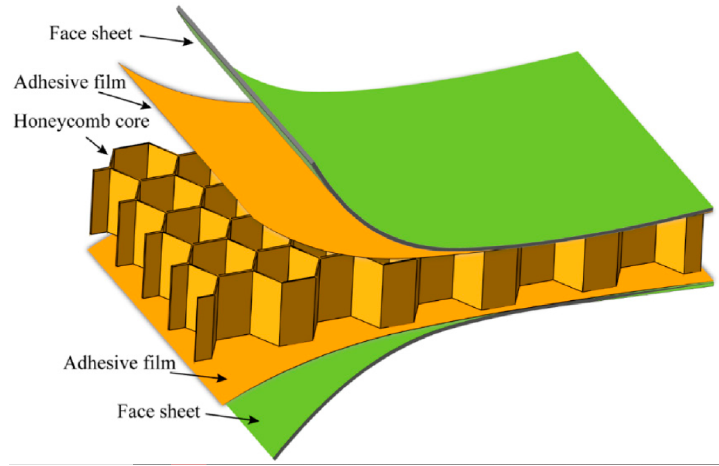
Figure 1. Schematic of basic sandwich panel configuration. Reprinted with permission from [3]. Copyright 2012, MDPI AG.